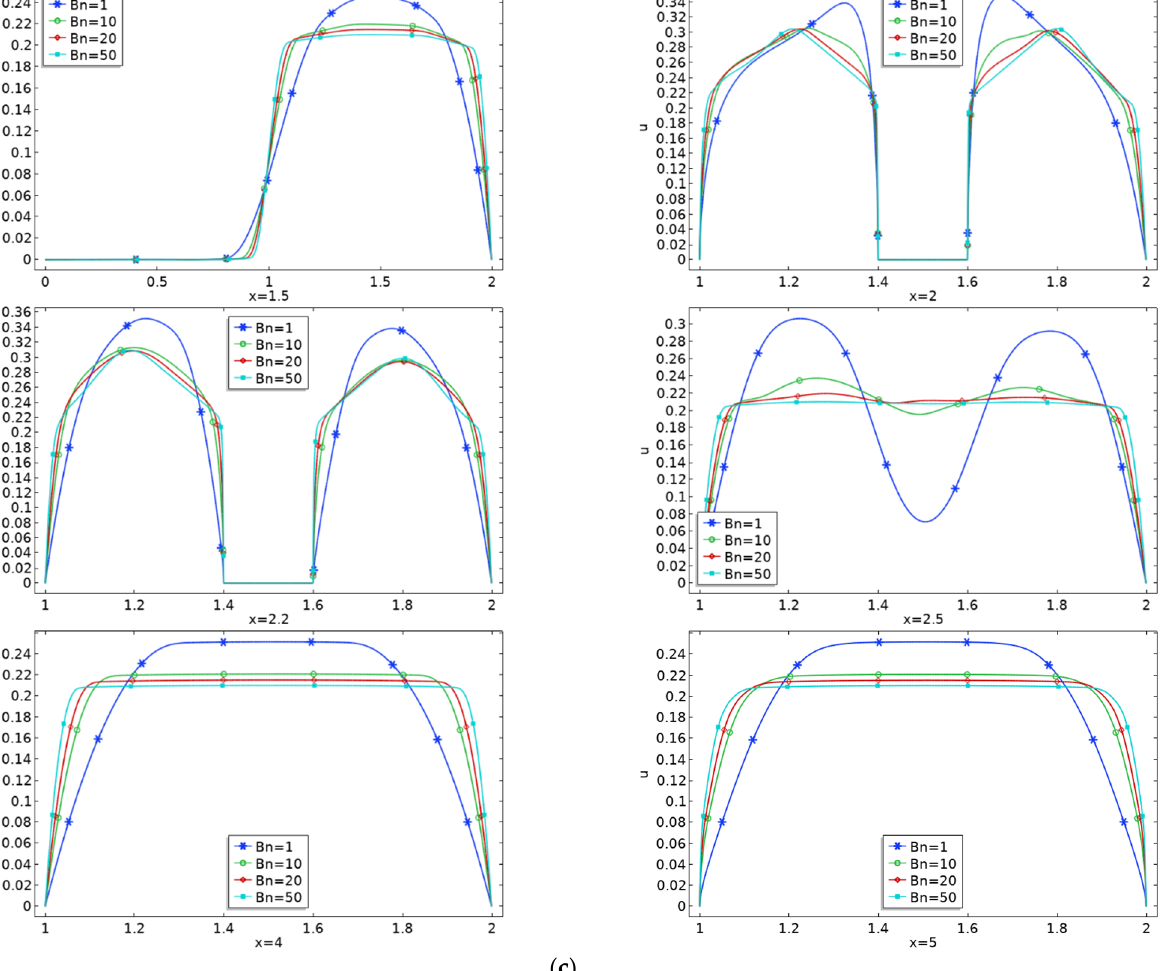
Figure 6. ( a ): Line graph of velocity profile when the center of obstacle at C 1 for various Bn . ( b ): Line graph of velocity profile when the center of obstacle at C 2 for various Bn . ( c ): Line graph of velocity profile when the center of obstacle at C 3 for various Bn